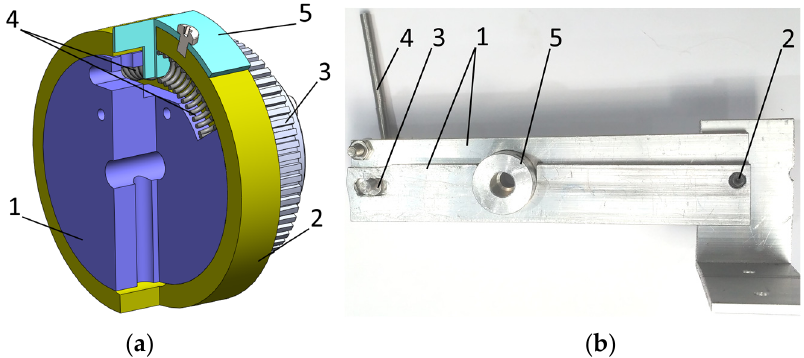
Figure 5. Haptic device elements: ( a ) step-to-torque-transforming bushing: 1 inner drum, 2 outer drum, 3 pulley, 4 springs, 5 partition; ( b ) the clamping mechanism: 1 aluminum strips, 2 axle, 3 eccentric, 4 handle, 5 bushing of the joint.